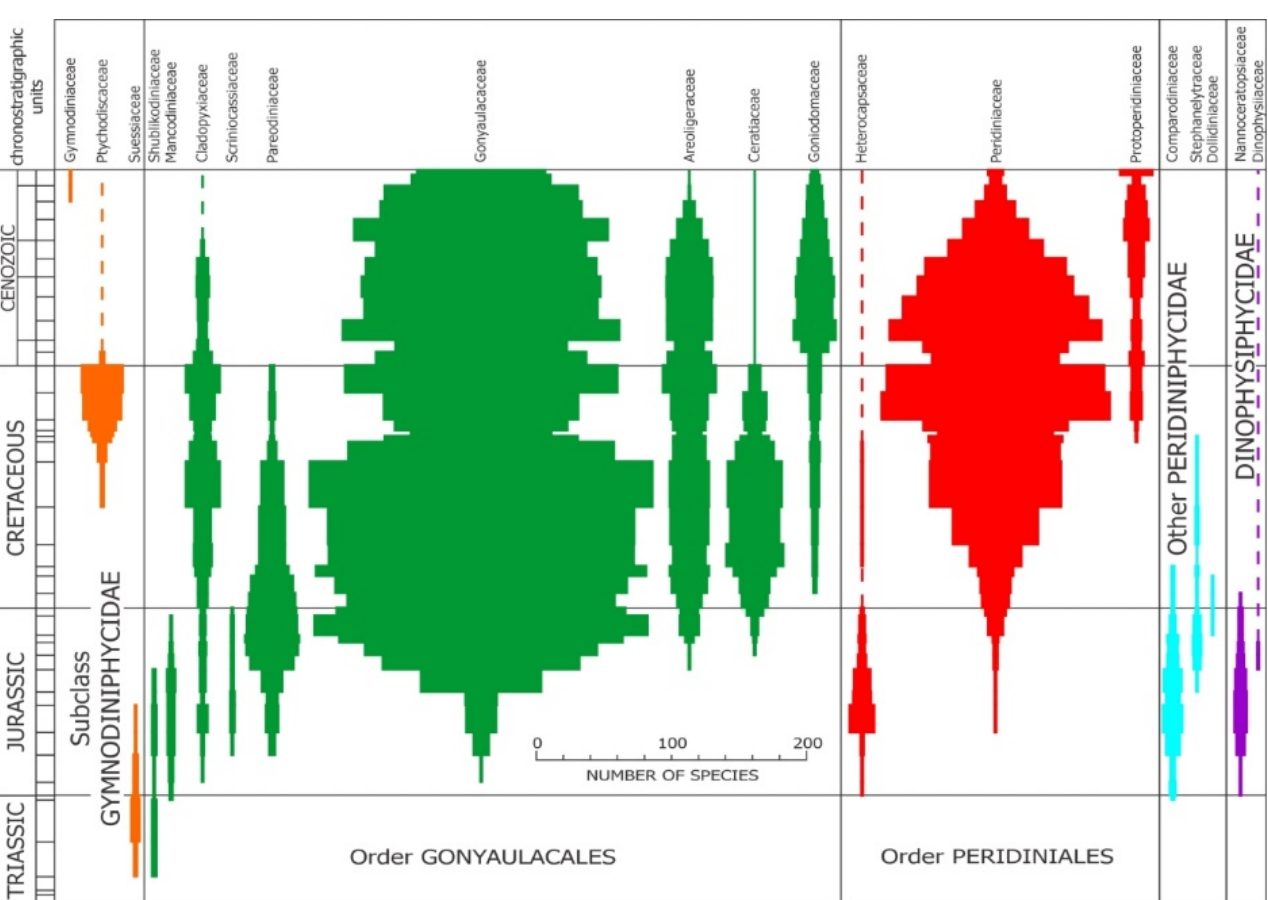
Figure 21. Spindle plots showing the number of species per family of fossil dinoflagellates per time interval (stages in the Triassic, Jurassic and Cretaceous and epochs and stages in the Cenozoic. Modified from [43], see for a fuller explanation. The colours are used to show more clearly higher taxonomic groupings.